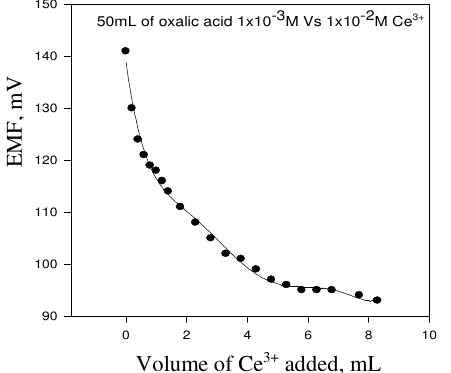
Figure 5. Titration curve of Ce(III) ions with oxalic acid solution using Ce(III)-selective electrode based on